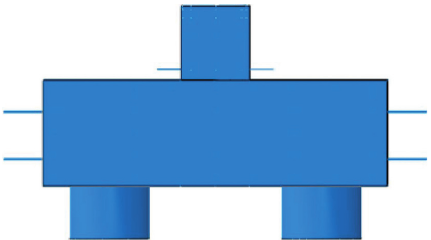
Figure 17: Foundation planting bar diagram of MT-1.